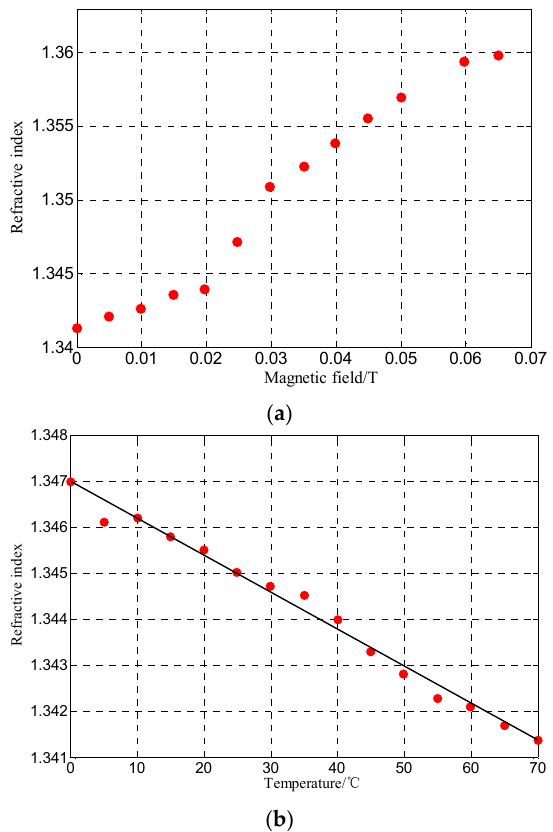
Figure 4. ( a ) Magnetic fluid refractive index variation versus transverse magnetic field; ( b ) Magnetic fluid refractive index variation versus temperature.